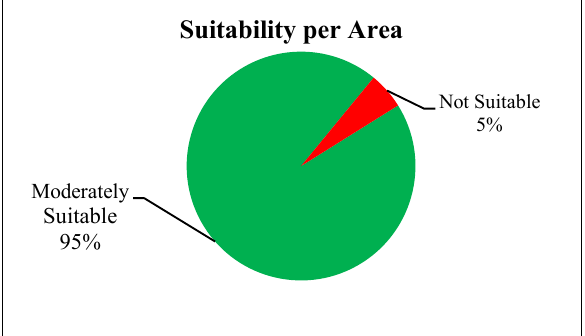
Figure 4. Suitability of the Existing Evacuation Centers per